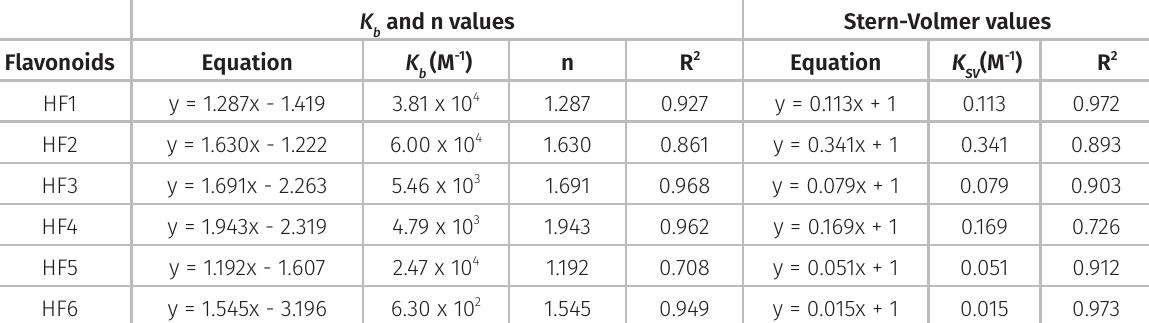
), number of attached moieties (n) and Stern-Volmer values for flavonoid-HSA b